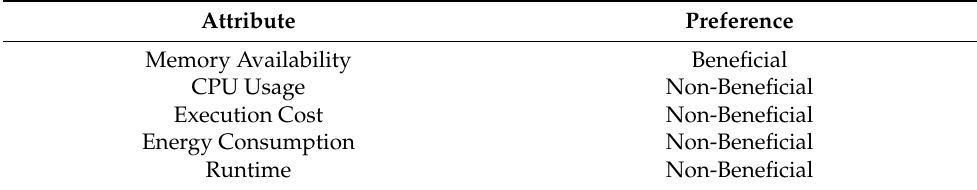
Table 4. OpERA criteria used for resource